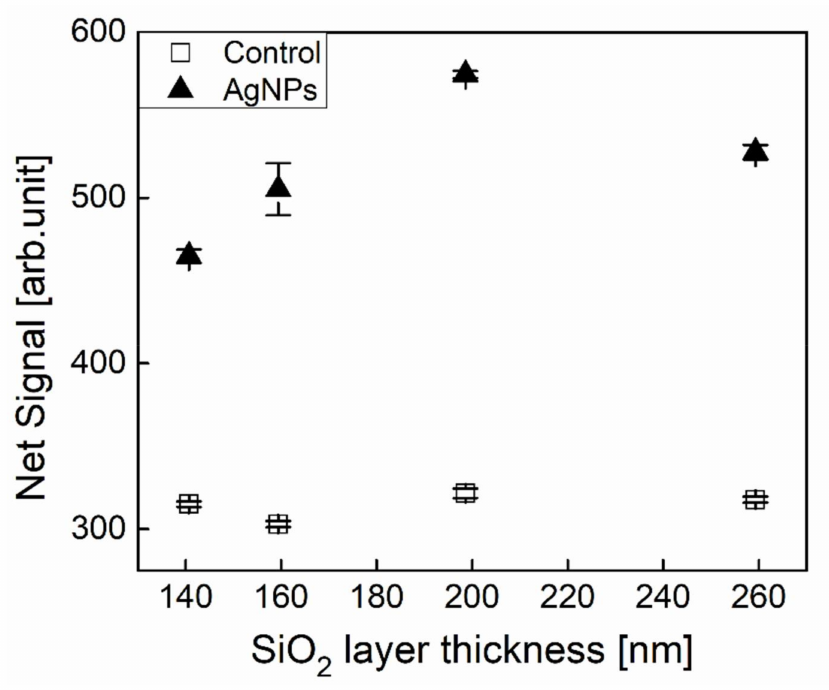
Figure 4. Net fluorescence signals obtained using the chips of Figure 1(b2) installed in the setup of Figure 3a. The thicknesses of the SiO2 layer wherein rhodamine 110 molecules were dispersed were 141, 159, 199, and 259 nm. Error bar = ± SD, n =